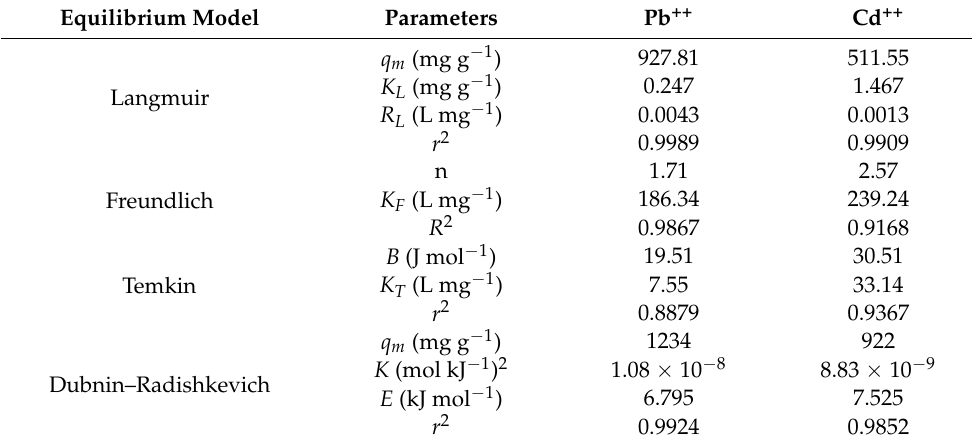
Table 4. Isotherm parameters for the adsorption of Pb ++ /Cd ++ ions onto MGCN sorbent. Equilibrium